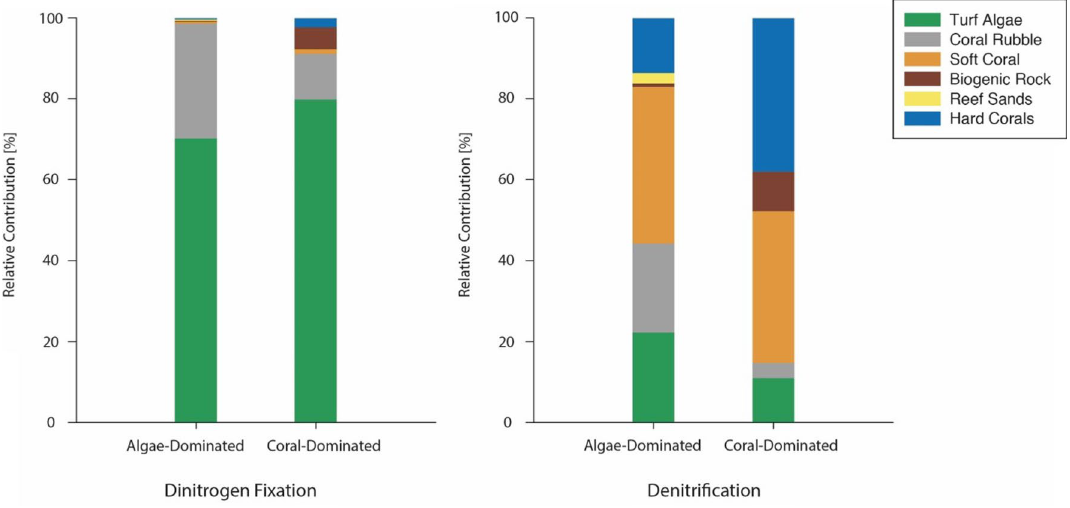
Figure 4. Relative contribution of studied benthic categories to total dinitrogen fixation and total denitrification in coral- and algae-dominated reef